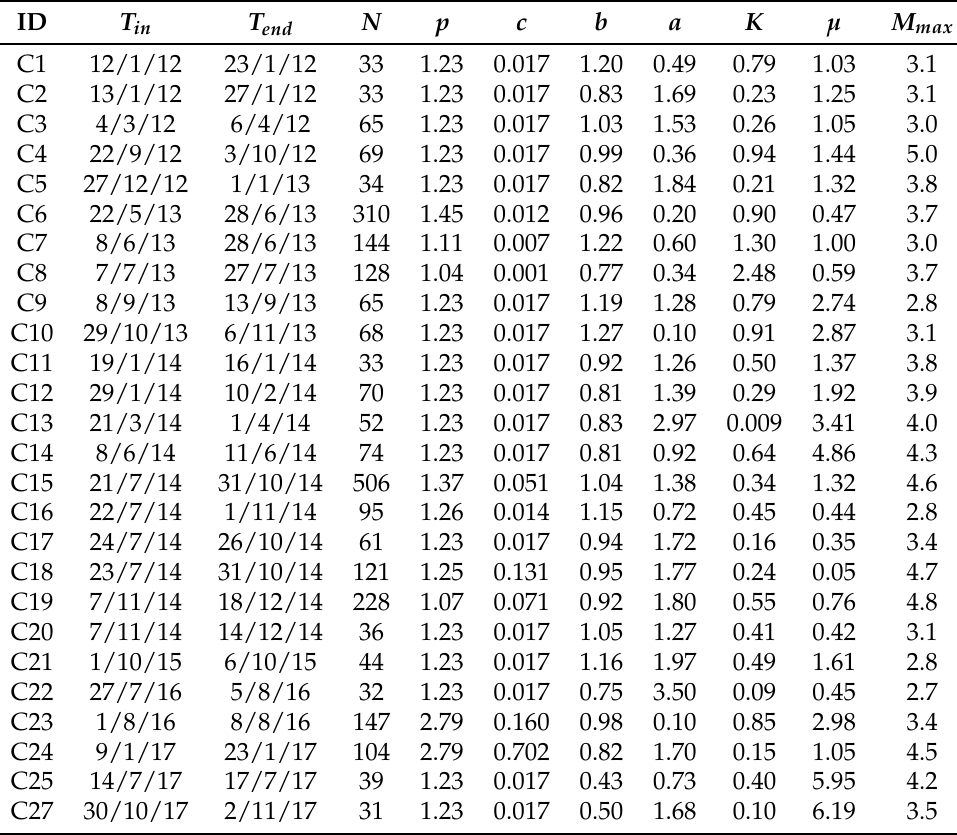
Table 6. Details on the 26 clusters with N ≥ 30 events in CG area and the inverted ETAS parameters. The generic values of the Omori law, p and c , are adopted for clusters with N <